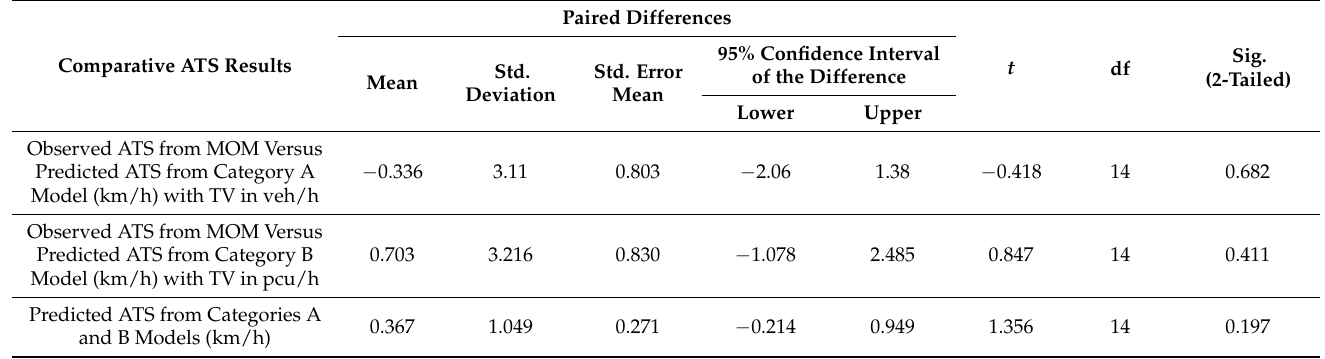
Table A2. Results of paired t -test for model of cross-sectional case of [M0, NL1, SF1].